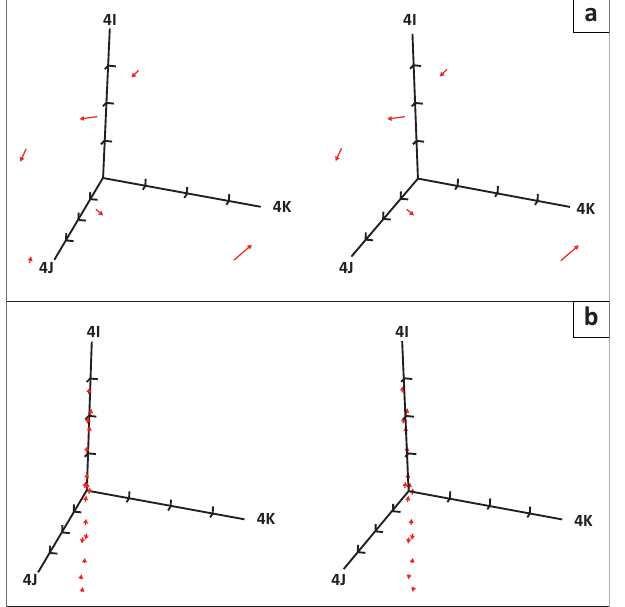
FIGURE 3: Stereo-pair scatter plots of comets joining the means of the measurements taken over two sessions: (a) for a group of eyes with keratoconus and (b) for a group of healthy control eyes. For each comet, the dot represents the mean of a set of 40 measurements taken in Session one for the eye concerned, and the comet ends at the mean of the measurements taken in Session two for the same eye. The origin is placed at the respective sample means. The axis lengths and tick intervals are 4 D and 1 D, respectively.